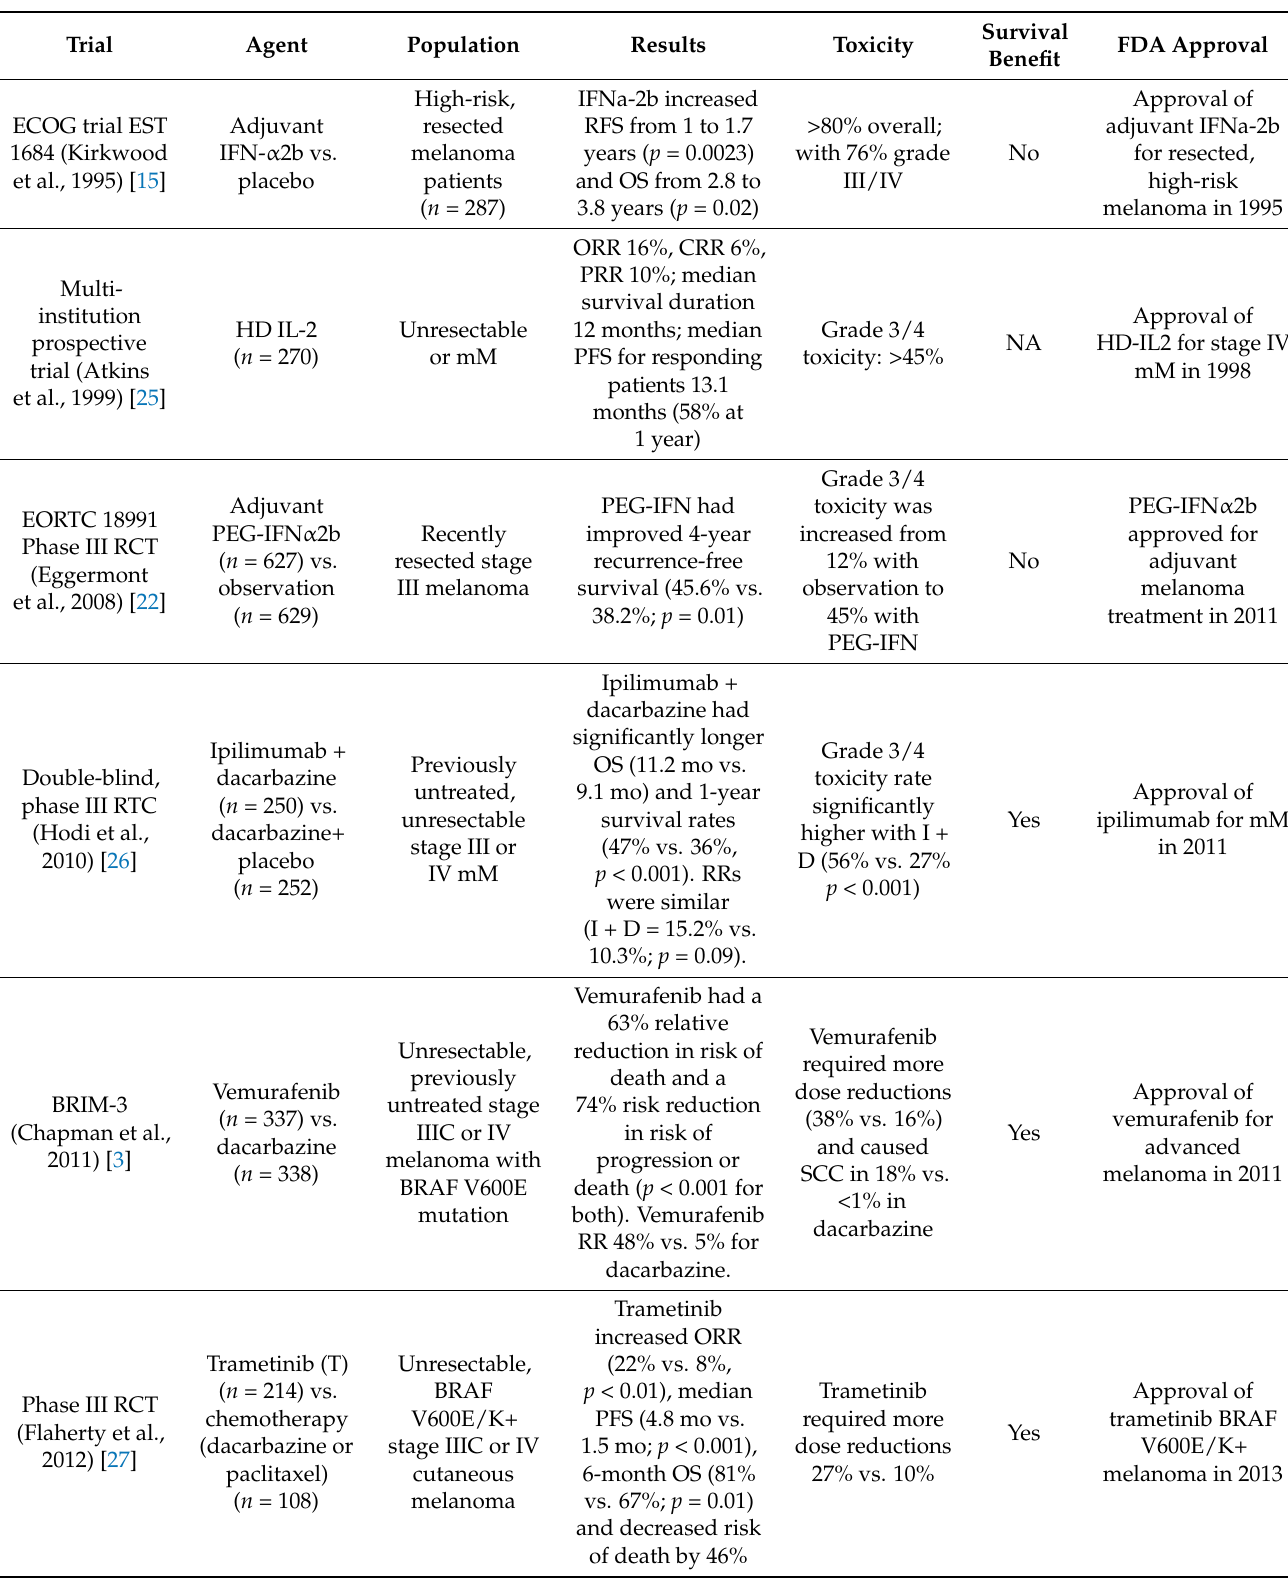
Table 1. Summary of approved treatments for metastatic melanoma and corresponding clinical